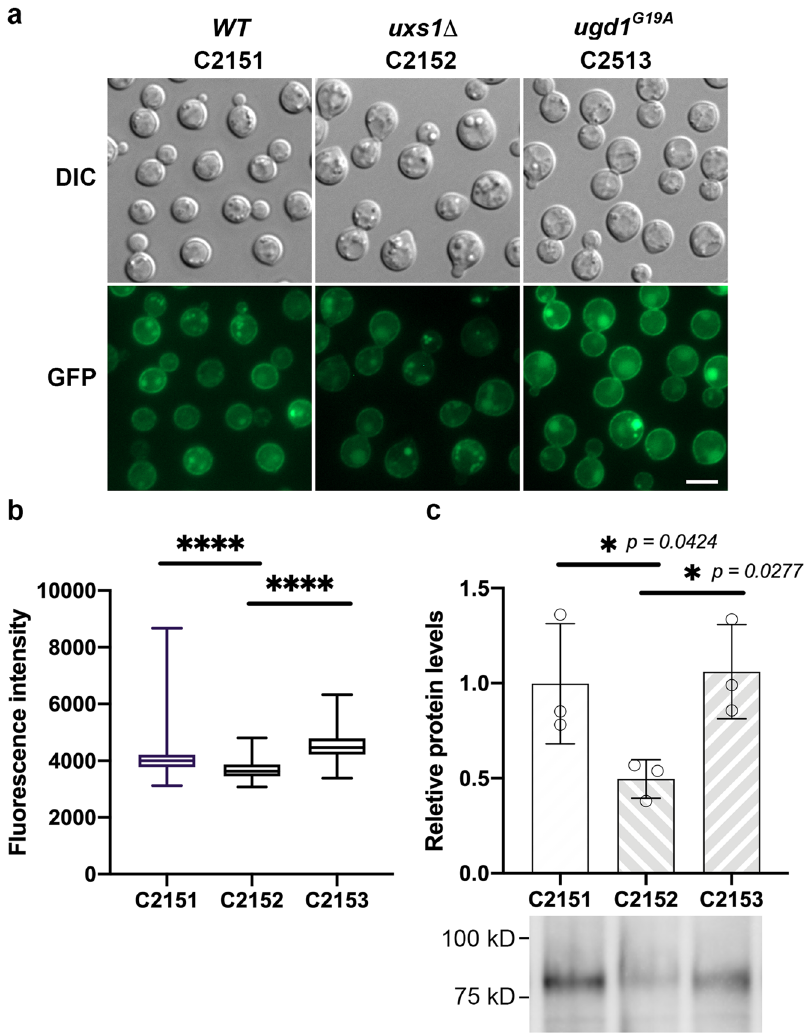
Fig. 8 Fcy2 protein levels are low in uxs1 mutants and high in the suppressor strains. a The localization of Fcy2 in the indicated strains was visualized by microscopy and photographed. Bar = 5 μ m. b The mean fl uorescence intensity of each strain from ( a ) were quanti fi ed from three separate images. The box-and-whiskers plot is used to show median, quartiles (boxes), and range (whiskers). One-way ANOVA with Tukey ’ s test for multiple comparisons (**** p < 0.0001). c The relative amounts of the FLAG tagged Fcy2 was analyzed by western blot (bottom) and the expression levels of Fcy2 were quanti fi ed by measuring the band intensity in the western blots, normalized to that of the total protein from stain-free blot and compared to the expression levels in C2151. For the full scan blots, see the Source data fi le. Data are presented as mean values± standard deviation from three biological repeats. One-way ANOVA with Tukey ’ s test for multiple comparisons (* p < 0.0332 and **** p <